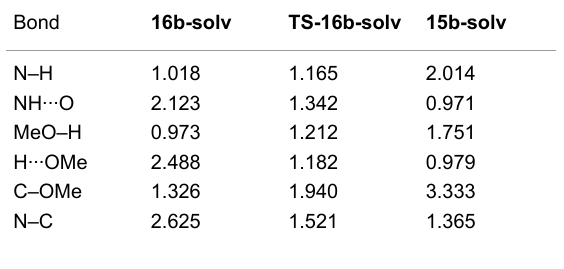
( Δ G = − 2.6 kcal mol − 1 ). Selected bond distances in Table 4